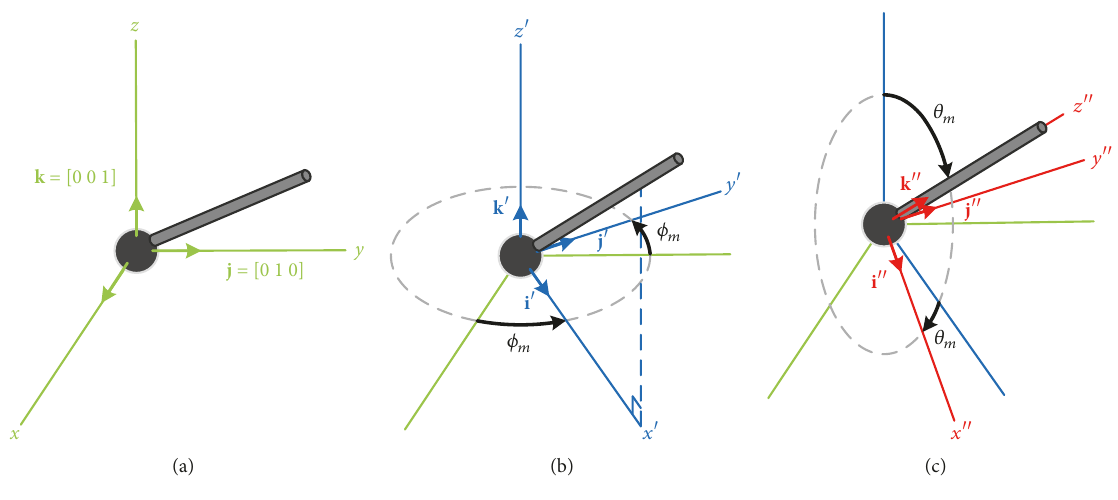
Figure 3: Coordinate transformation